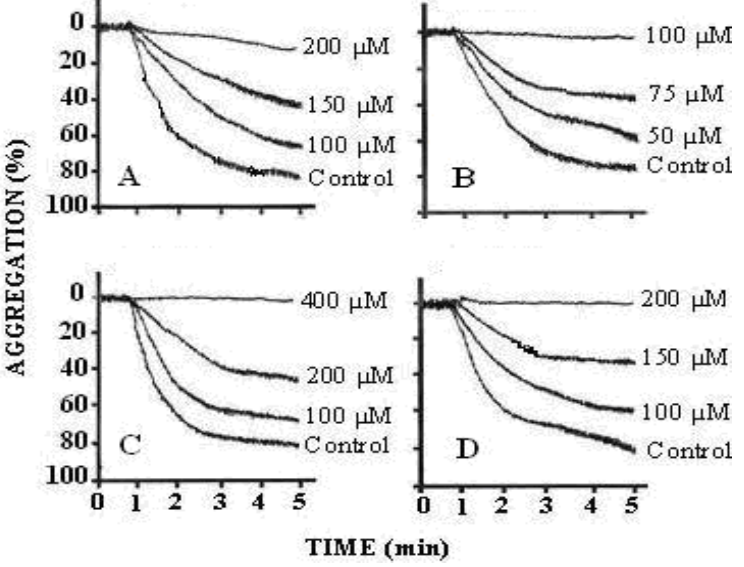
Figure 4. Tracings from the representative experiments showing the effect of various inhibitors on arachidonic acid induced platelet aggregation. (A = compound 1 ; B = compound 2 ; C = compound 3 and D = aspirin showing inhibition of arachidonic acid induced platelet aggregation in a dose-dependent manner. Control = arachidonic acid (1.73 mM), N = 8–10.